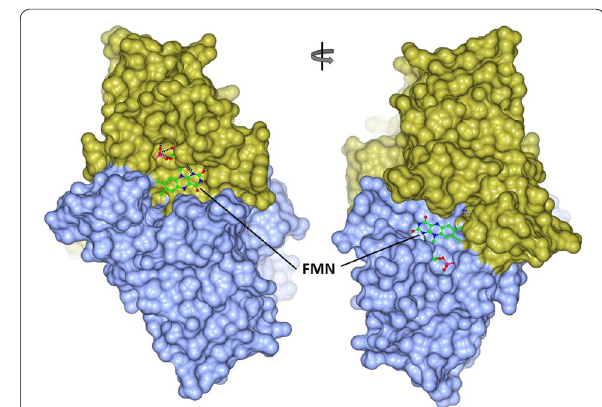
Fig. 2 Crystal structure of dimeric flavin-dependent azoreductase (AzrA) (PDB 3W77): green and blue are the monomers of FMN- containing azoreductase bound to each other and form a dimer. All flavin-containing azoreductases are dimeric as the FMN is bound in an active site formed by the two